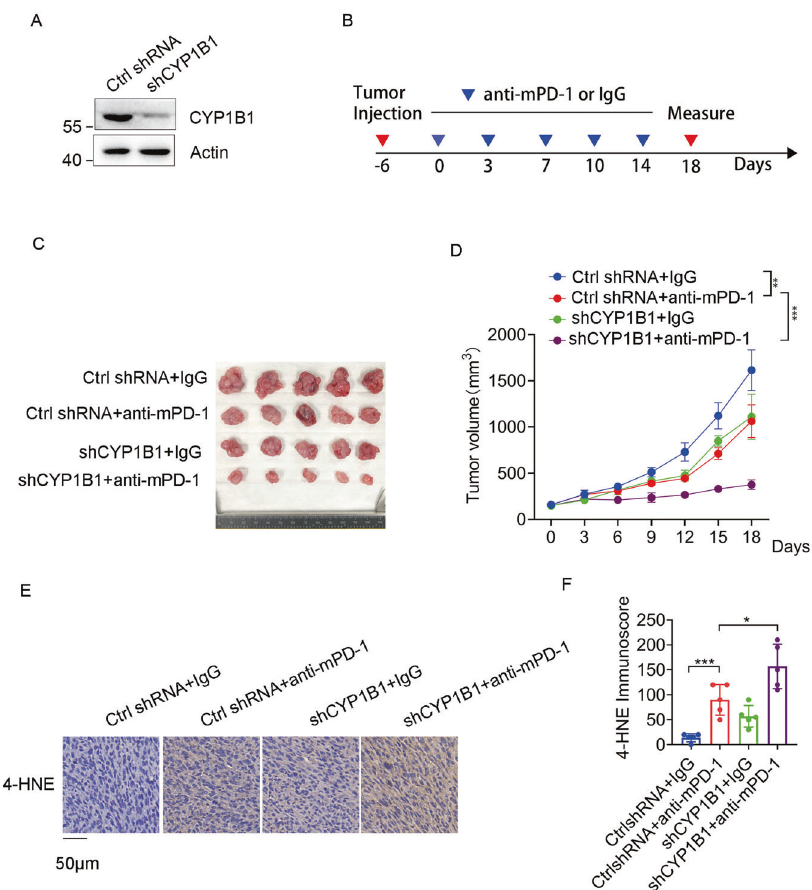
Fig. 4 CYP1B1 expression attenuates the effect of anti-PD-1 therapy. A Western blot analysis of MC38 cells expressing ctrl shRNA or CYP1B1 shRNAs. B C57BL/6 J mice carrying the indicated MC38 cell formed tumors at the right fl ank were treated with anti-mPD-1 antibody or isotype control IgG for a total of fi ve treatments. C , D Tumor images C and tumor growth curve D in mice bearing indicated MC38 cell tumors treated with anti-mPD-1 or isotype control IgG antibodies. E IHC staining of 4-HNE in MC38 tumors expressing ctrl or CYP1B1 shRNA. F Quanti fi cation of 4-HNE IHC staining. n = 5 per group. p value was determined by Student ’ s two-sided t test. * p < 0.05, ** p < 0.01, *** p <